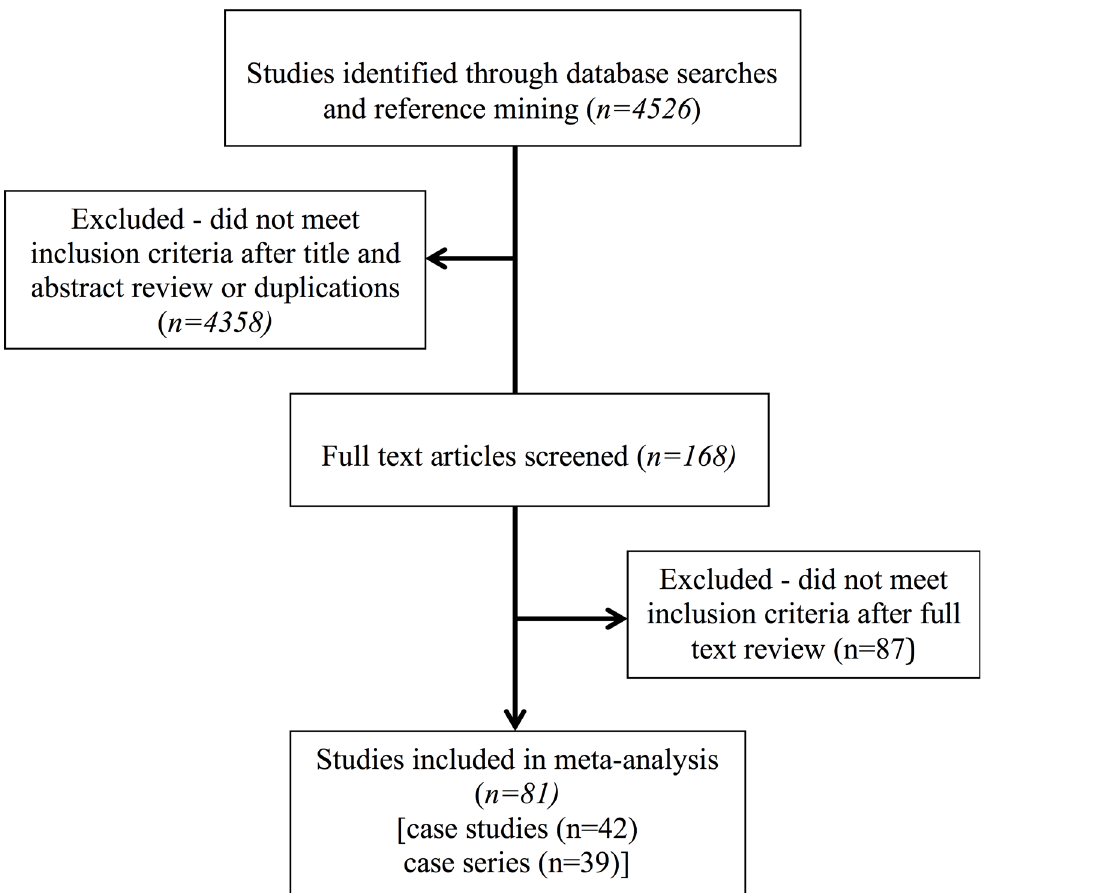
Fig 1. Flow diagram of the study selection